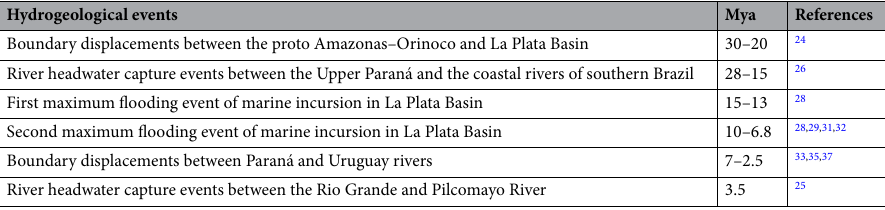
Table 1. Documented past hydrogeological events in La Plata